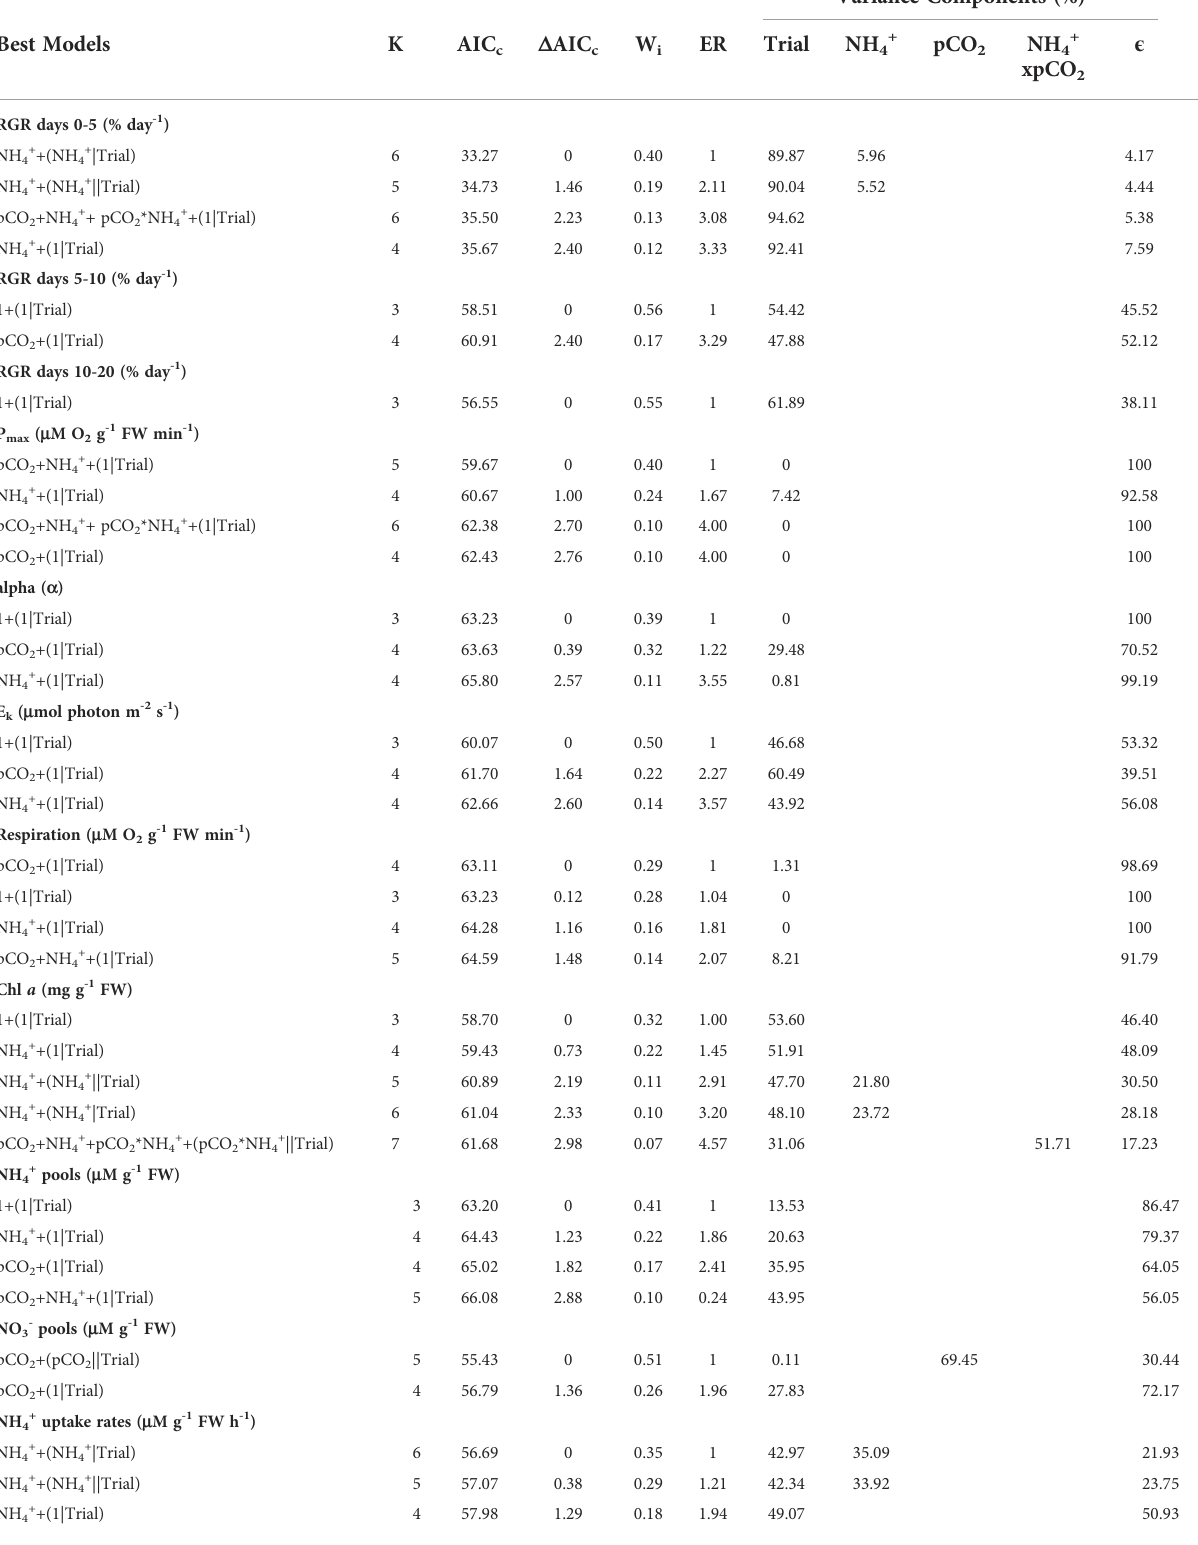
TABLE 3 Summary of most supported models ( D AIC c ≤ 3) and variance